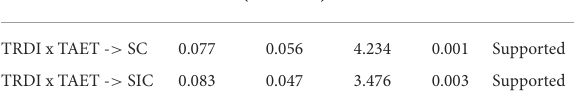
TABLE 3 Discriminant validity.